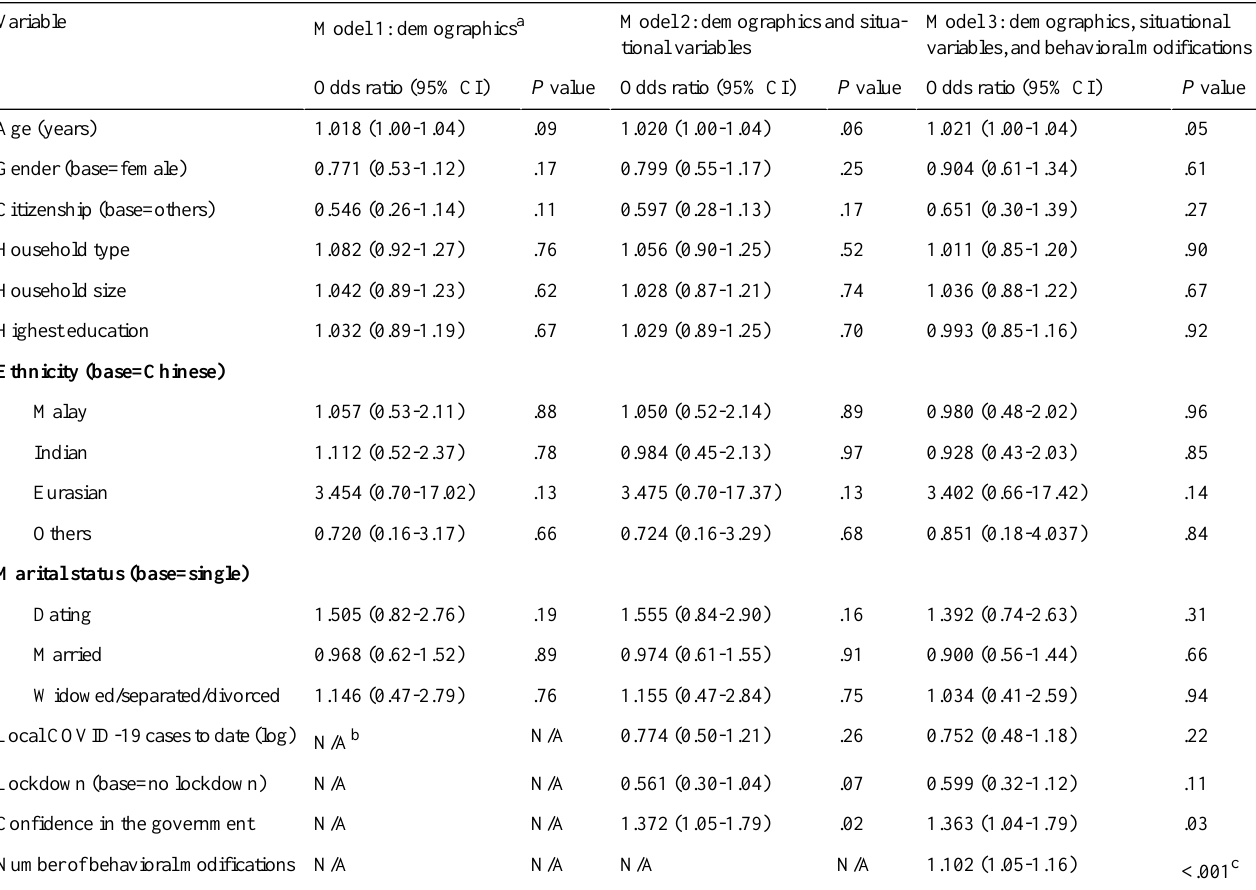
Table 3. Logistic regression models of predictors of the uptake of TraceTogether (dependent variable=downloaded TraceTogether).